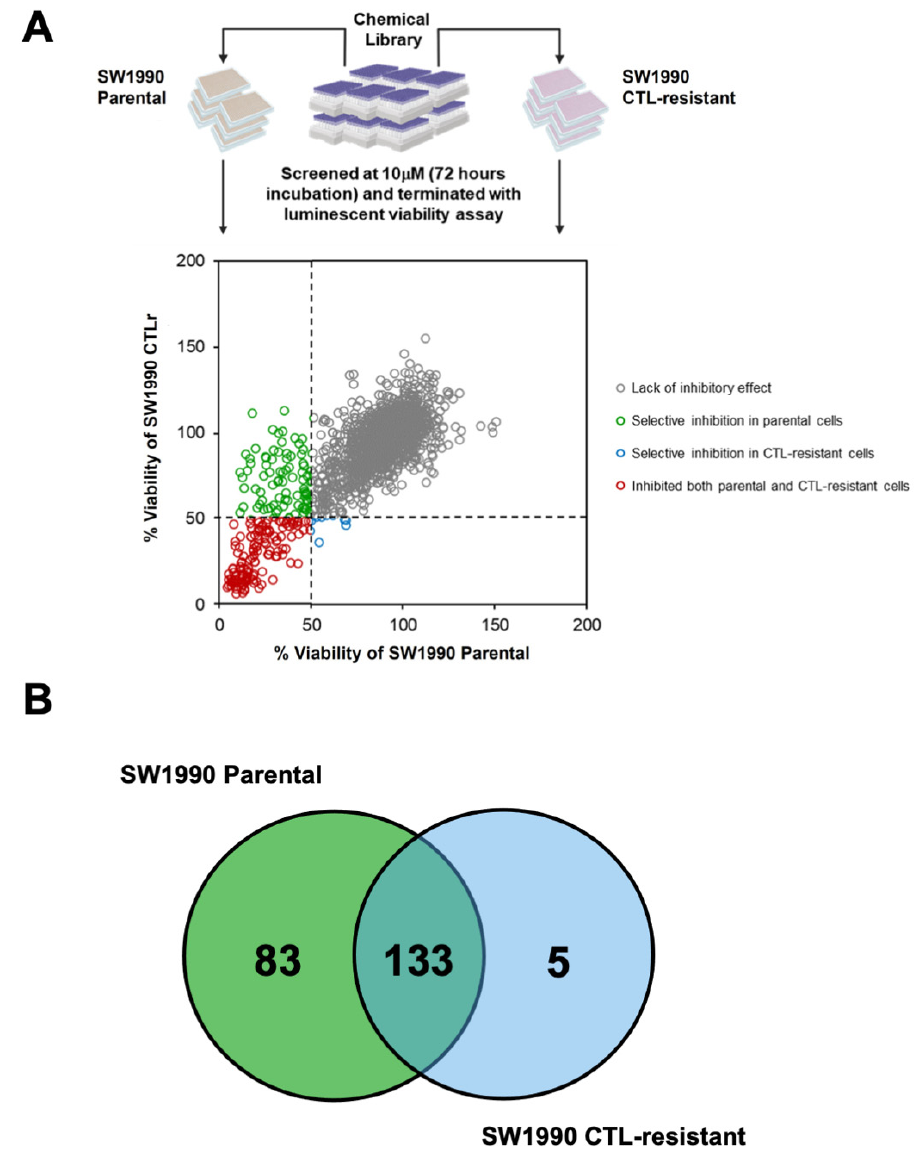
Figure 3. High-throughput phenotypic screen identifies 133 bioactive small molecules targeting both parental and CTL-resistant SW1990 cells. ( A ) A total of 1672 small bioactive molecules were screened in parental and CTL-resistant SW1990 cells at 10 µM for 72 h and terminated with CellTiter-Glo ® Luminescent Cell Viability Assay (Promega Corporation, Madison, WI, USA). By combining the screening data from both lines, compounds that exerted inhibitory effects against both parental and CTL-resistant cells were identified. Green circles, molecules targeting parental SW1990 cells only; blue circles, molecules targeting SW1990 CTLr; red circles, molecules targeting both parental and CTL-resistant SW1990 cells; grey circles, molecules lacking anti-proliferative activities. ( B ) Compounds which inhibited both parental and CTL-resistant SW1990 cells (cell inhibitory effect < 50%) were considered “hits”. Table 3. Top ten targets of hit compounds identified to inhibit both parental and CTL-resistant PDAC.